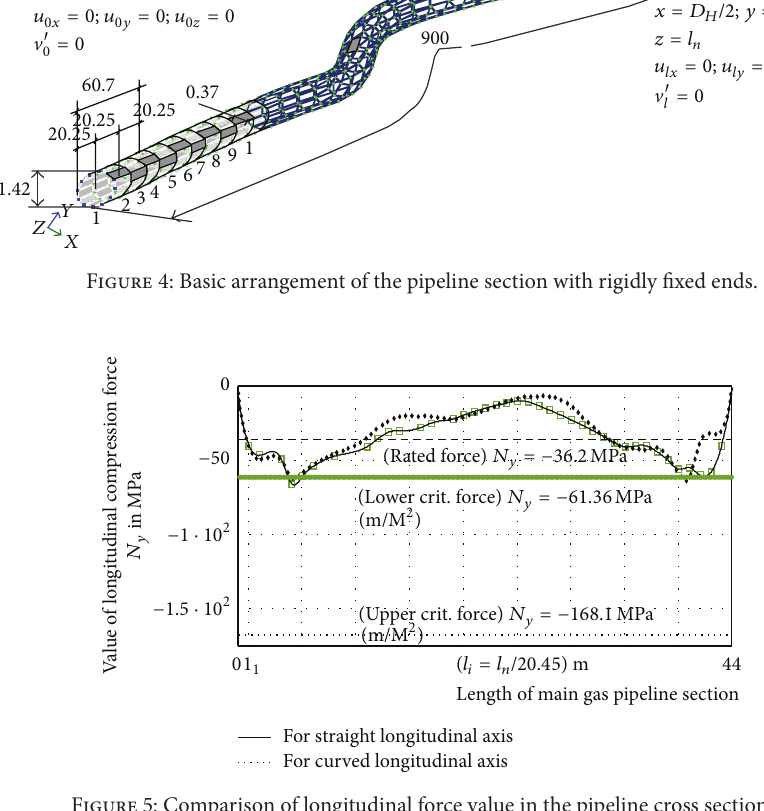
Figure 5: Comparison of longitudinal force value in the pipeline cross section.